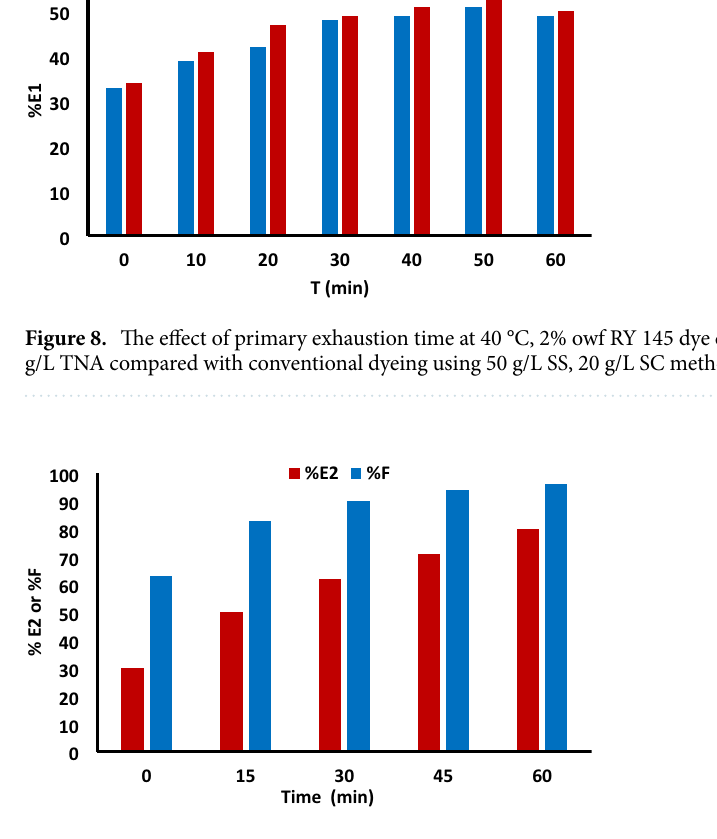
Figure 9. The effect of secondary exhaustion time and fixation using 50 g/L TNA, 2% owf, RY 145 dye, LR 1:40 at 70 °C.